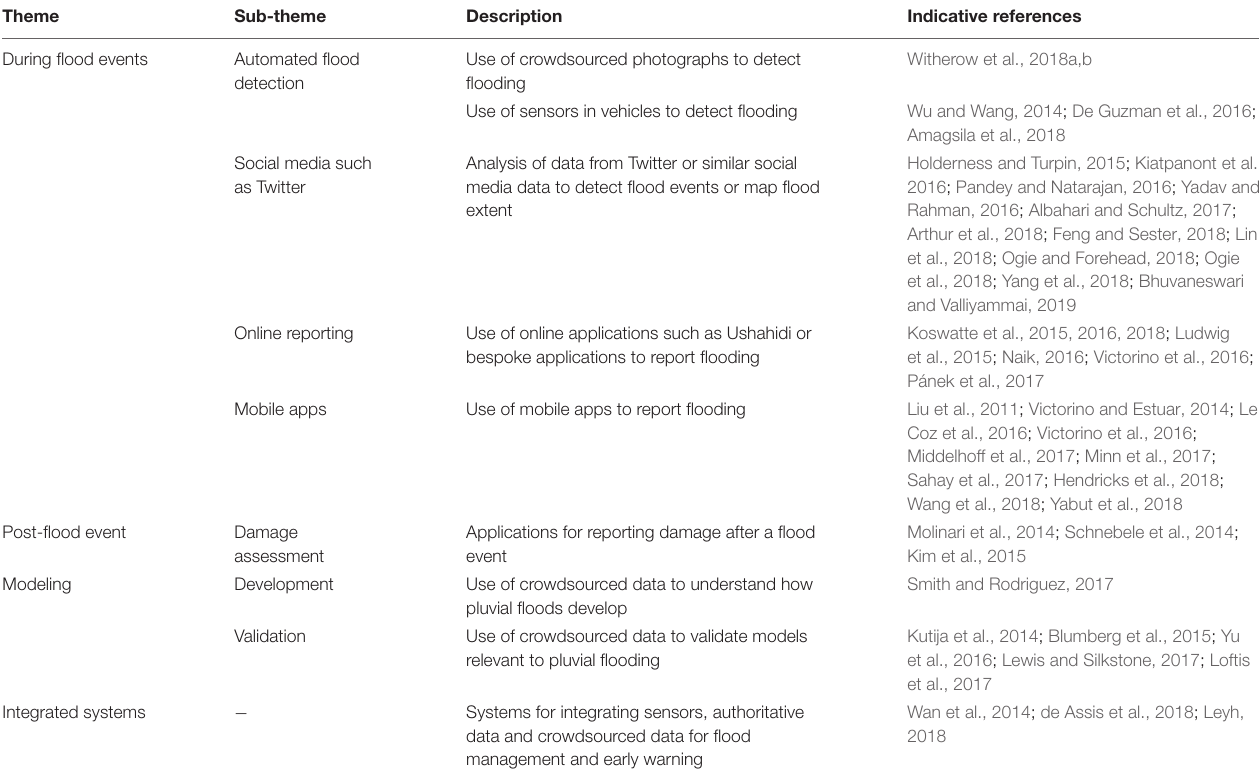
TABLE 1 | The main themes in the literature regarding citizen science, crowdsourcing and pluvial flooding (or with potential for application to pluvial flooding), with indicative